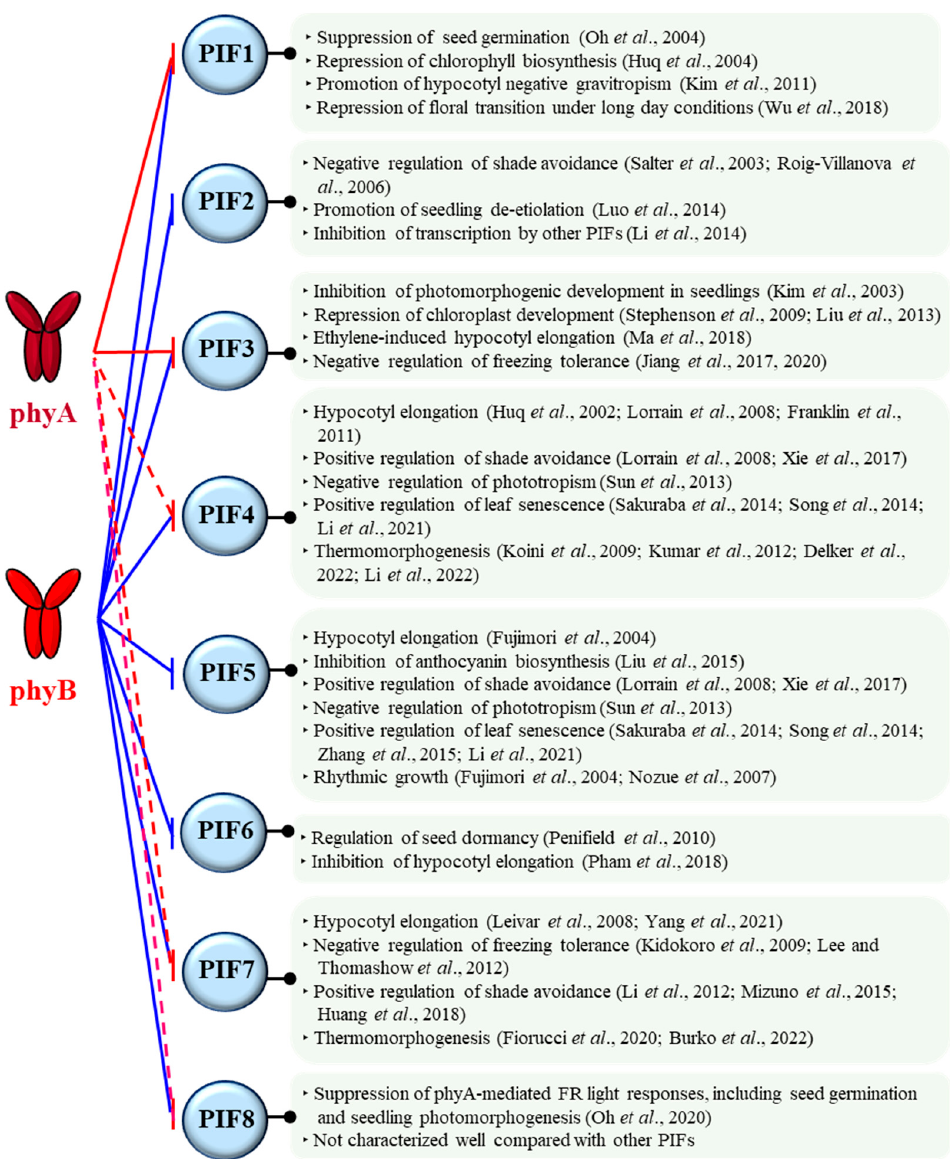
Figure 2. The functions of eight PIFs identified in Arabidopsis. In general, photoactivated phyto- chromes negatively regulate PIFs by molecular mechanisms such as phosphorylation and subse- quent proteolysis, sequestration, and compartmentation. Arabidopsis phyB interacts with all eight PIFs that have an active phyB-binding (APB) motif (shown as blue lines). In contrast, only PIF1 and PIF3 have an active phyA-binding (APA) motif, showing interaction with phyA (red lines). However, it is noted that APA-lacking PIF4, PIF7, and PIF8 can also interact with phyA, although their binding affinities to phyA are much lesser than that to phyB (red dashed lines) [29,48,49,51– 53,56,57,59–92].